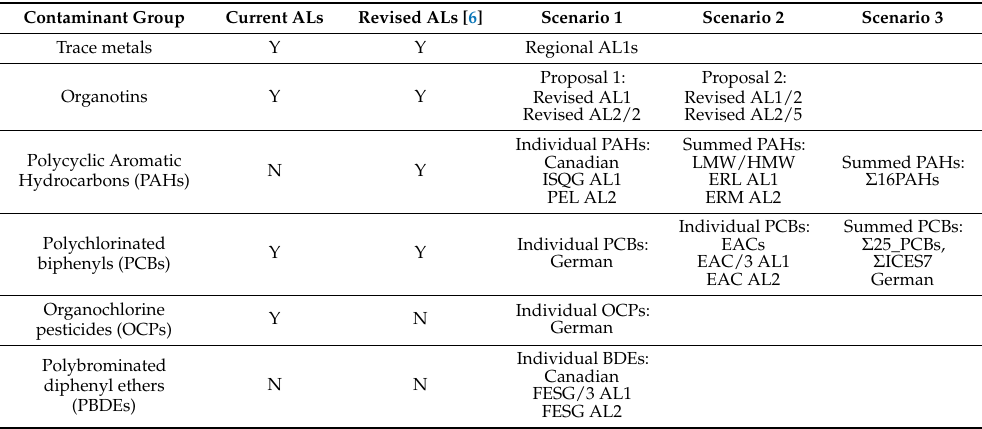
Table 1. Data scenarios tested as part of the Action Level Review. Expanded details for each scenario are given in the Results section (Section 3). The columns indicate current ALs, revised ALs, and then details of other scenarios tested for each contaminant group.